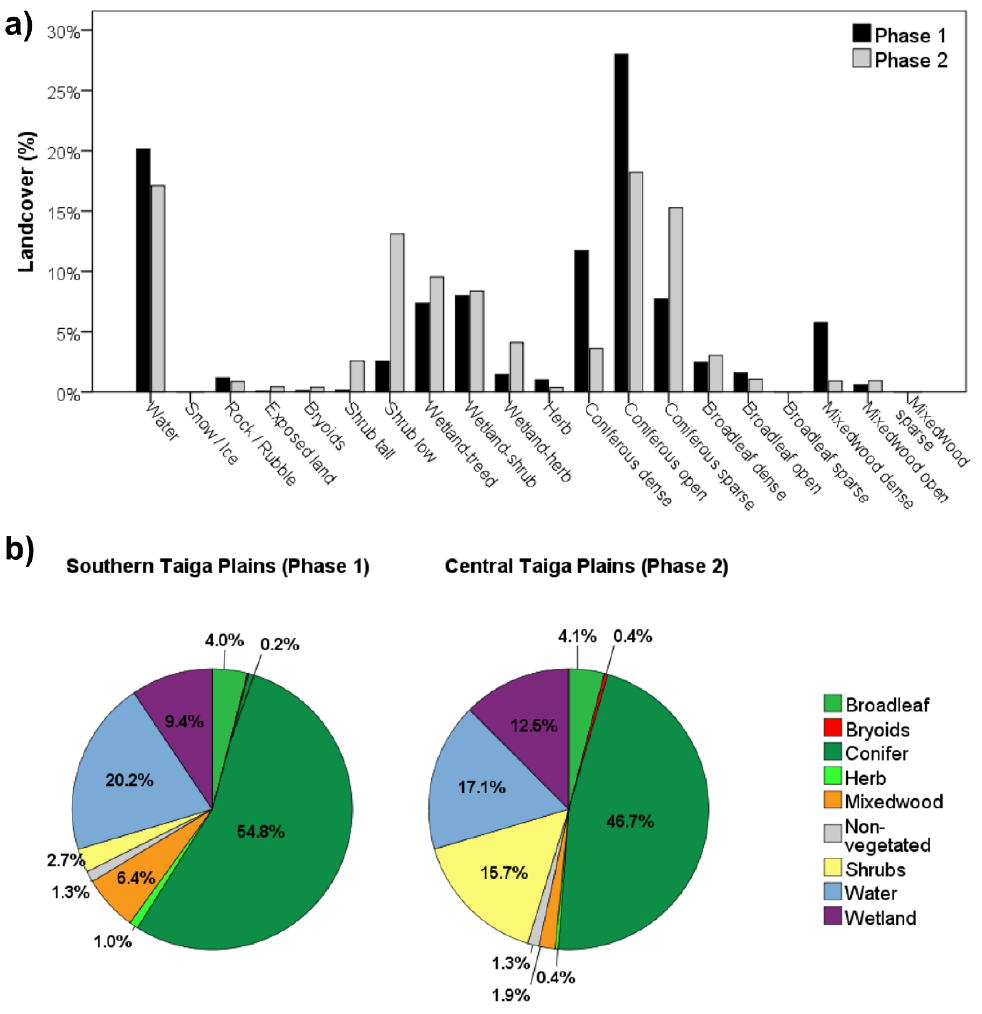
Figure 4. Histogram of the mapped landcover classes for two levels of classification detail: ( a ) level 5 (vegetation type plus density; 17 classes), and ( b ) level 4 (vegetation type; 9 classes), for Phases 1 and 2 of the MVI project, roughly corresponding to southern and central Taiga Plains, respectively.